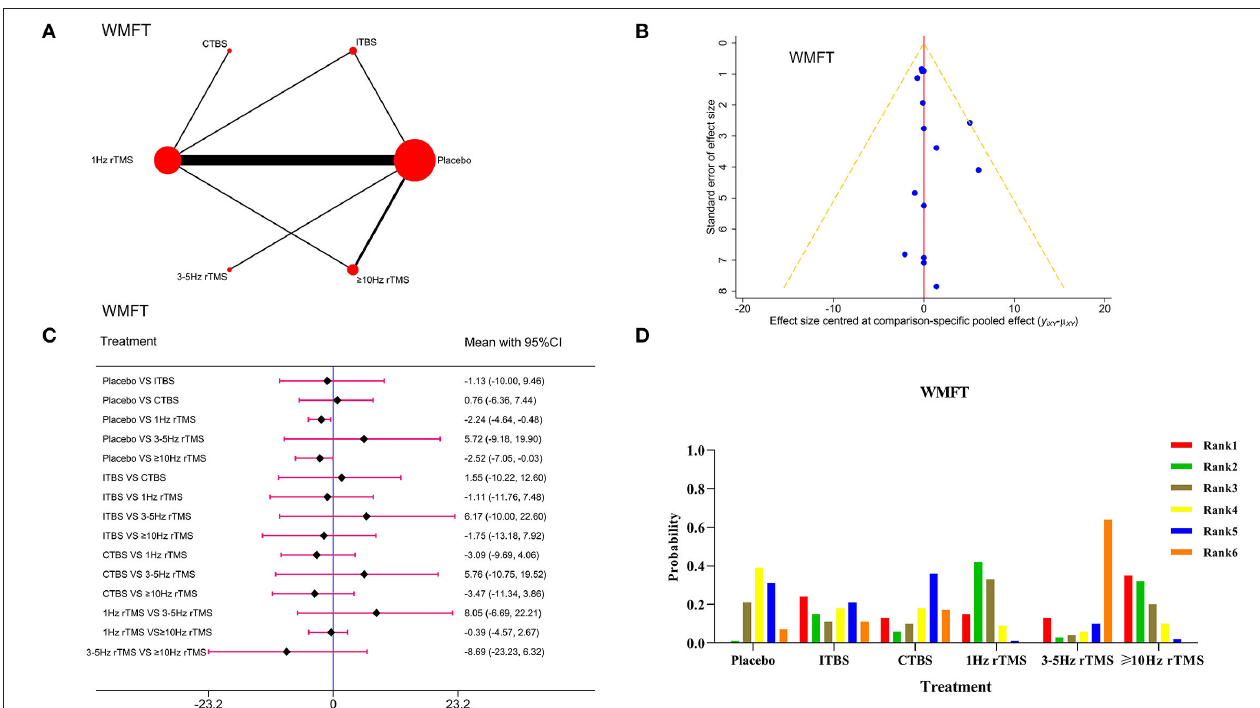
FIGURE 3 | Network meta-analysis results for Wolf Motor Function Test (WMFT). (A) : Network plot; (B) : Funnel plot; (C) : Forest plot; (D) : The figure of ranking probability.